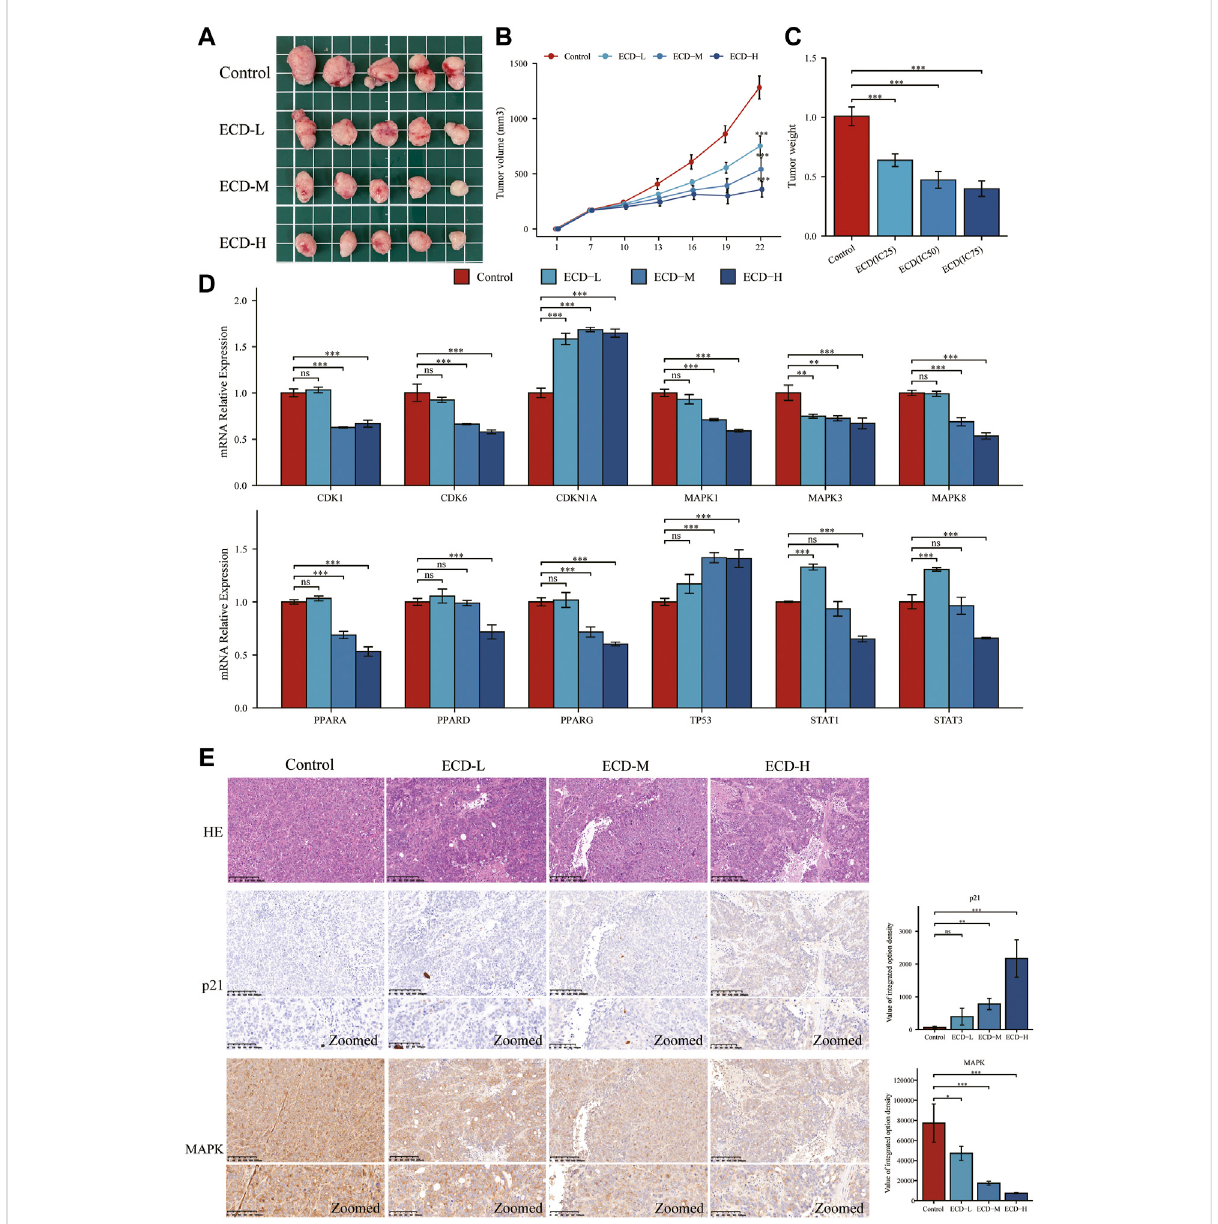
FIGURE 11 ECD inhibited tumor growth in mice. (A) The anti-tumor effects of ECD in mice. (B) Variations in tumor volume in mice during ECD treatment ( n = 5). (C) Variations intumorweightsafter ECD treatment ( n =5). (D) ThemRNA relativeexpressionlevels ofCDKs, CDKN1A, MAPKs, PPARs, STATs, andTP53intumorxenograftsafterECDtreatment. (E) HEstainingandIHCresultsoftumorxenograftsindifferentgroups. ns P > 0.05,* p < 0.05,** p < 0.01, *** p <